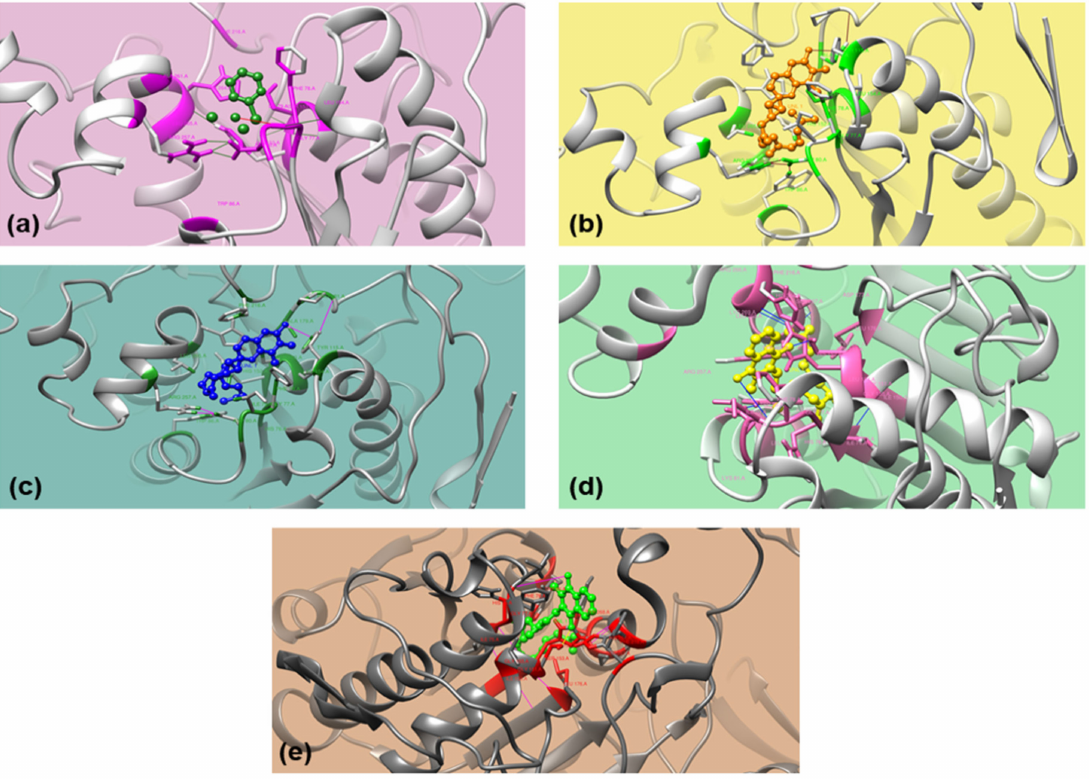
Figure 3. 3D orientation of the docked conformations of 1ETH with ligands. ( a ) Betahistine; ( b ) α -Tocopherol; ( c ) γ - Tocopherol; ( d ) Tocopheryl acetate; and ( e ) Phytonadione. PPL has intrinsic fluorescence attributed to phenylalanine (Phe), tryptophan